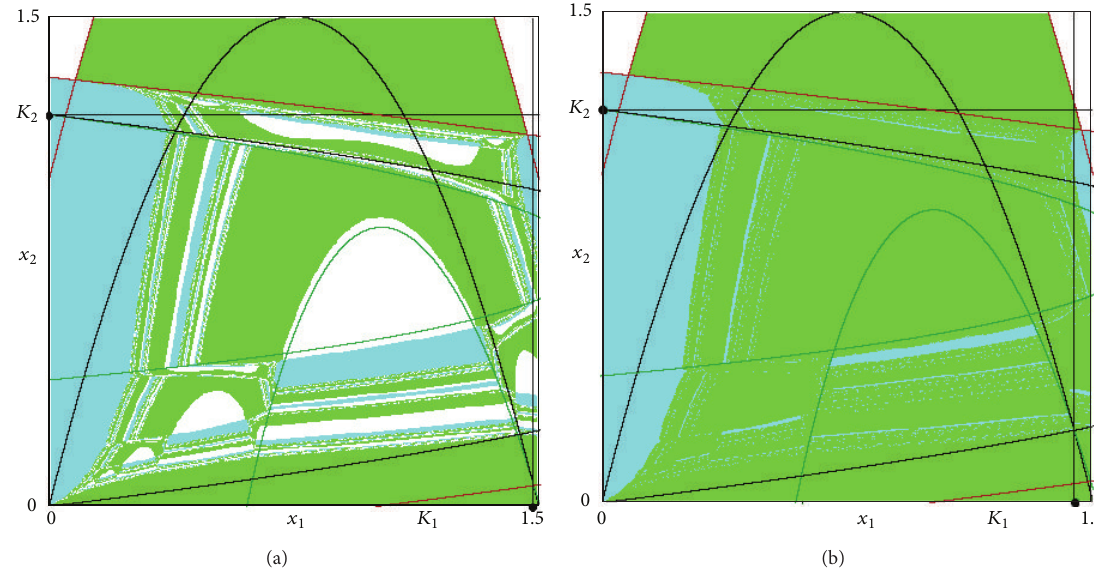
Figure 11: Parameters: 𝑁 1 = 1.5 , 𝑁 2 = 1.2 , 𝜏 1 = 4 , 𝜏 2 = 8 , 𝛾 1 = 𝛾 2 = 1 , and 𝐾 2 = 1.2 . Panel (a) 𝐾 1 = 1.48 . Panel (b) 𝐾 1 = 1.44 . The green (resp., azure) region is the basin of attraction of the superstable equilibrium of segregation (𝐾 1 , 0) (resp., (0,𝐾 2 ) ), the white region is the basin of attraction of the equilibrium of extinction (0,0)